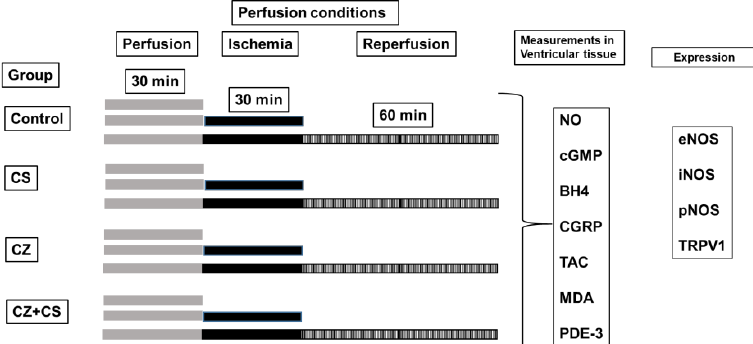
Figure 1. Experimental conditions. Each experimental group (Control, CS, CZ and CZ+CS) was sub- jected to different conditions: 1. — Pe (perfusion) 30 min. 2. — Pe 30 min + I (Ischemia) 30 min, without reperfusion (R). 3. — Pe 30 min + I (30 min) + Reperfusion for 60 min. Global ischemia was induced by stopping coronary flow by turning off the perfusion pump. Left ventricular tissue samples were obtained from all experimental conditions and frozen at −70 °C until metabolite detection tests were performed.